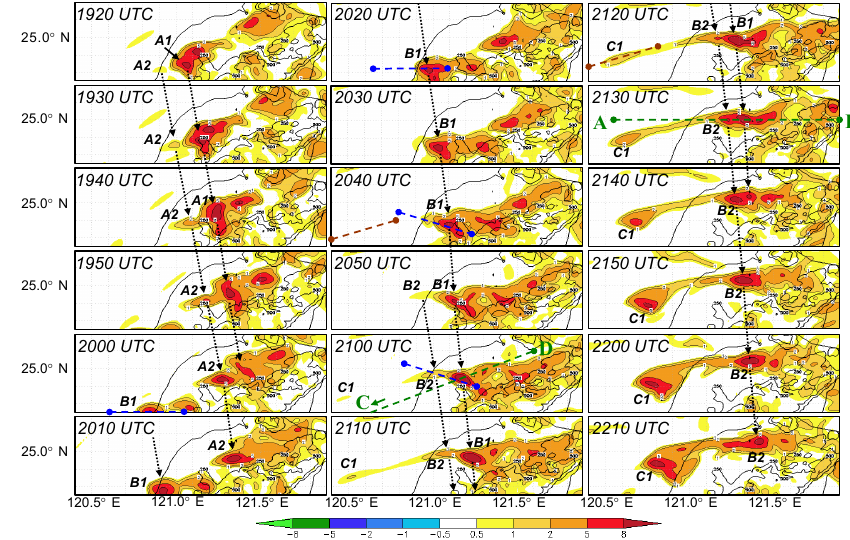
Figure 10. Model-simulated column-maximum vertical velocity ( w , ms − 1 , color and thin contours) every 10min during 19:20–22:10UTC on 11 June 2012, overlaid with terrain elevation (m, thick contours at 250 and 500m) in northern Taiwan. The color scale is shown at the bottom, and the contour at 0.5ms − 1 is not drawn. Old cells (A1, B1, and C1) and nearby new cells (A2, B2) of interests are labeled. Green dashed lines AB and CD depict the vertical cross sections used in Fig. 11, and the short segments depict those used in Figs. 14–18 (blue (brown) ones through B1 (C1)).